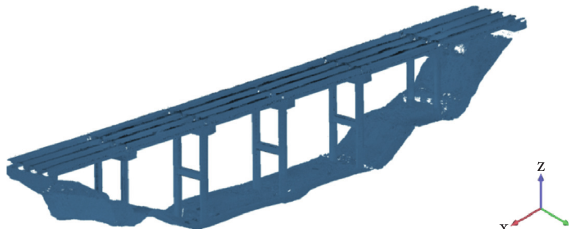
Figure 15: Construction bridge point cloud after